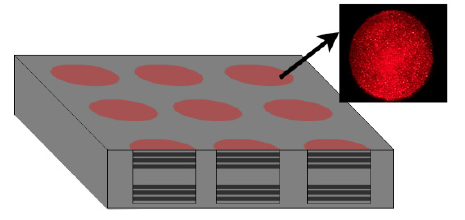
Figure 13. Bragg biosensor structure.